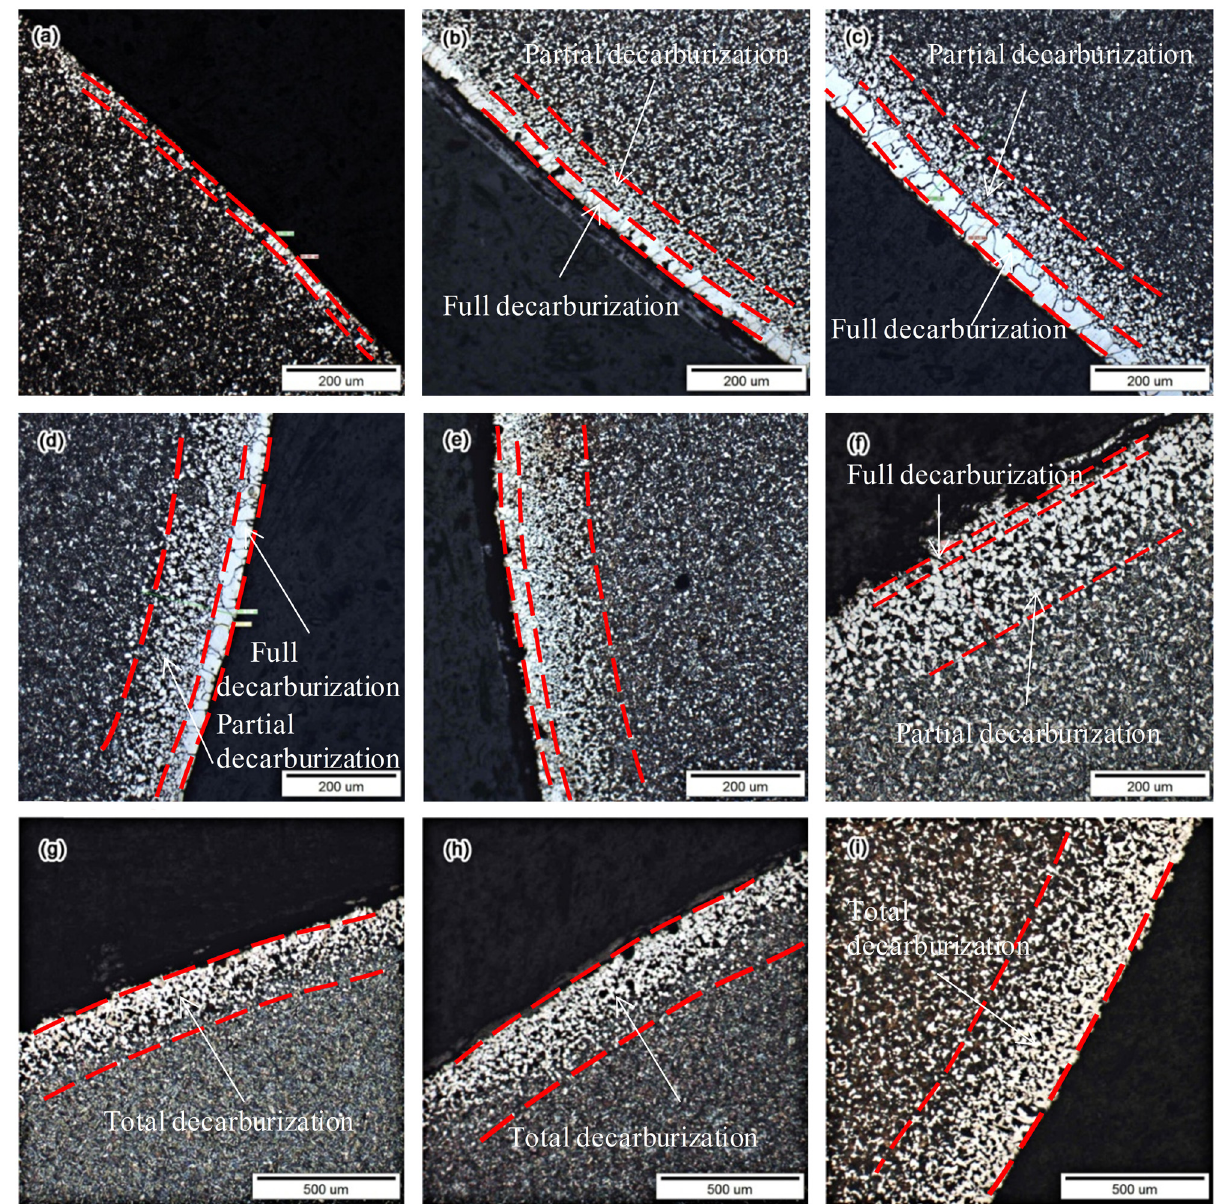
Figure 2: Decarburization of original steel samples observed at di ff erent temperatures for 30 min: ( a ) 700°C, ( b ) 750°C, ( c ) 800°C, ( d ) 850°C, ( e ) 900°C, ( f ) 950°C, ( g ) 1,000°C, ( h ) 1,050°C, and ( i )